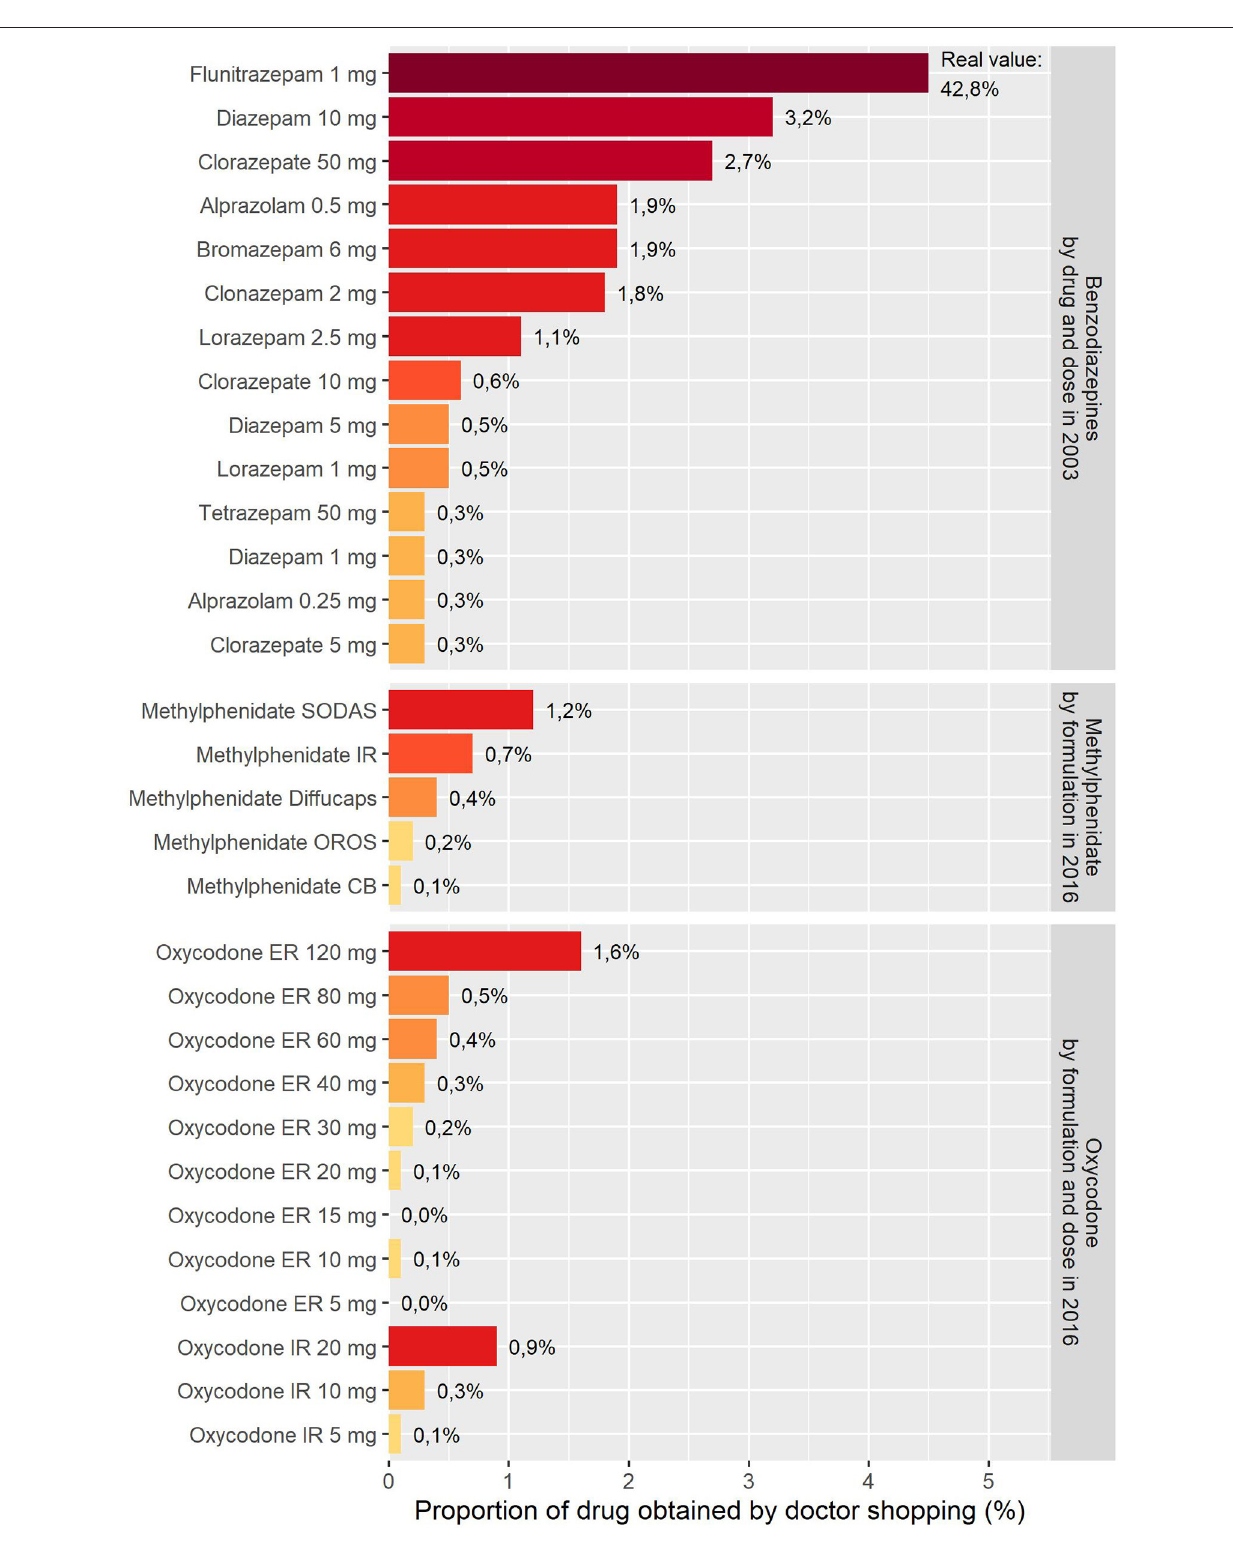
Frontiers in Psychiatry |